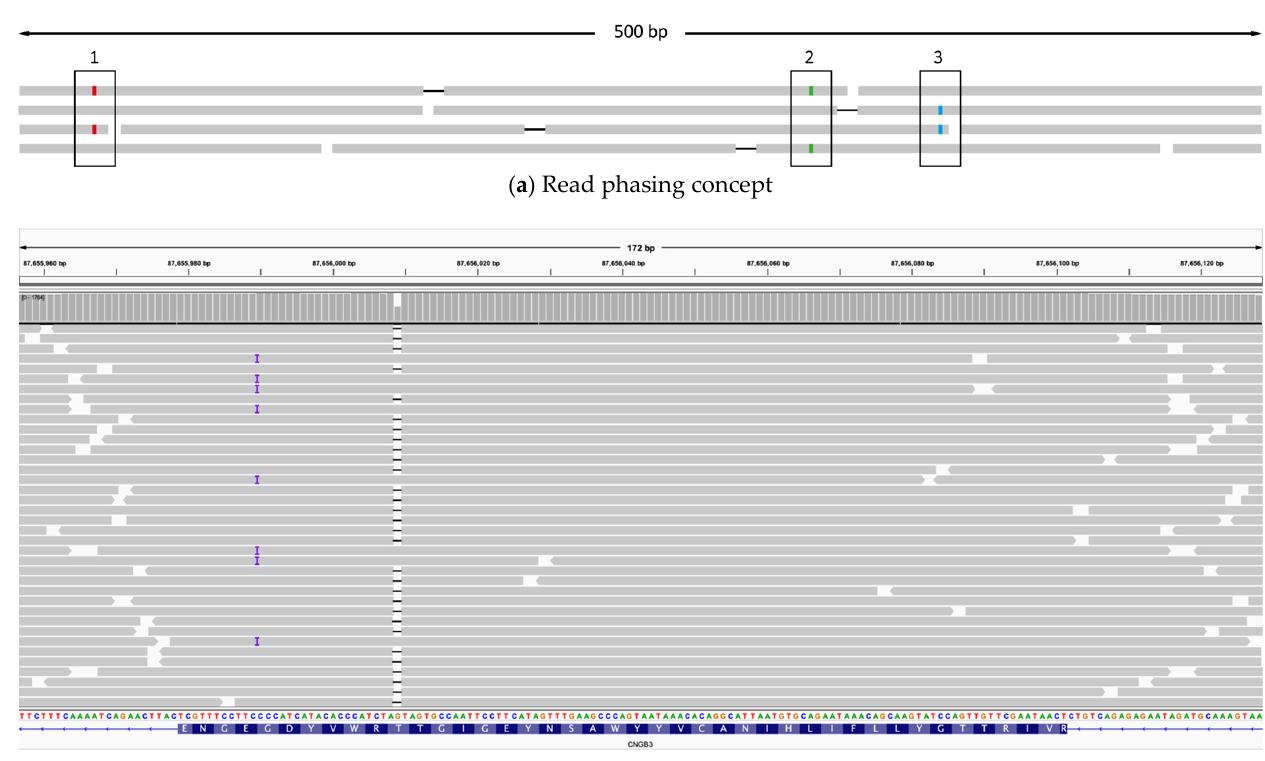
Figure 2. Read phasing: ( a ) Conceptual representation of read phasing. The grey bars represent sequencing reads aligned to the genome. Mate pair reads are connected by a black line. Single nucleotide variants are shown by a colored line and highlighted by black boxes. In this representation, variants at position 1 and 3 are the two putative pathogenic variants. The mate pair read on the top left is evidence that variants 1 and 2 are in cis. On the other hand, mate pair reads on the second and third lines attest that variants 2 and 3 are in trans. Therefore, variants 1 and 3 are in trans. ( b ) Screenshot from Integrative Genomics Viewer (IGV) of a simple example of read phasing from this study. The illustration shows the location of the two potentially pathogenic variants for patient S220 ( CNGB3 :c.1148del and CNGB3 :c.1167_1168insC). Table 2. Macular dystrophies (MD) cohort summary. Abbreviations: STGD, Stargardt disease;